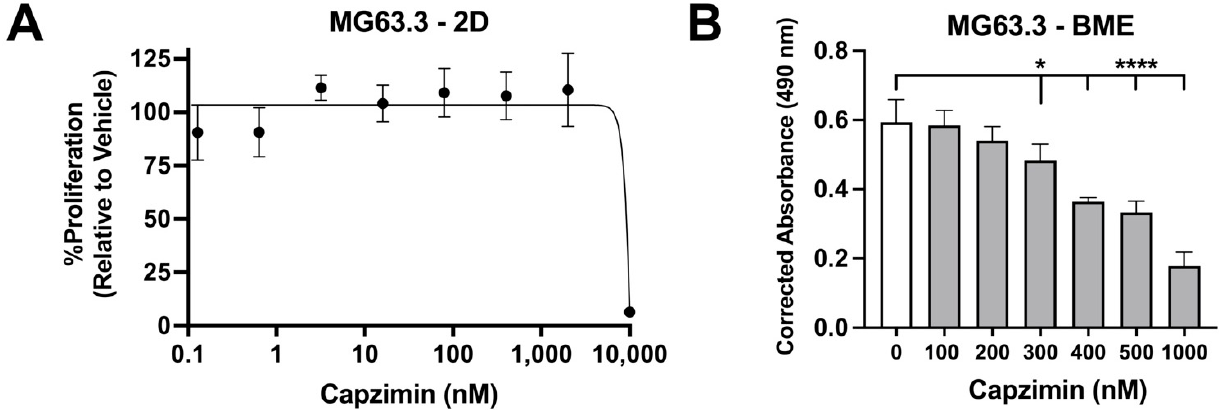
Figure 7. Human OS cells are more sensitive to capzimin when cultured under 3D conditions. ( A ) CZM was unable to blunt proliferation up to a 2 µ M dose in MG63.3 cells treated in 2D conditions for 6 days. Graph depicts the relative absorbance values at 490 nm and normalized to the DMSO (vehicle) control and represents the mean ± SD from n = 3 independent experiments. ( B ) CZM significantly decreased growth under 3D conditions. MG63.3 cells were cultured in a 3D Basement Membrane Extract (BME) system and subjected to various doses of CZM treatment for 6 days. Growth was significantly decreased by CZM at 300, 400, 500 and 1 μ M concentrations (* p < 0.05 and **** p < 0.0001). Graph depicts corrected absorbance values at 490 nm with BME + media alone used to subtract background. The results are representative of one of 2 experiments, each with 4 technical replicates.